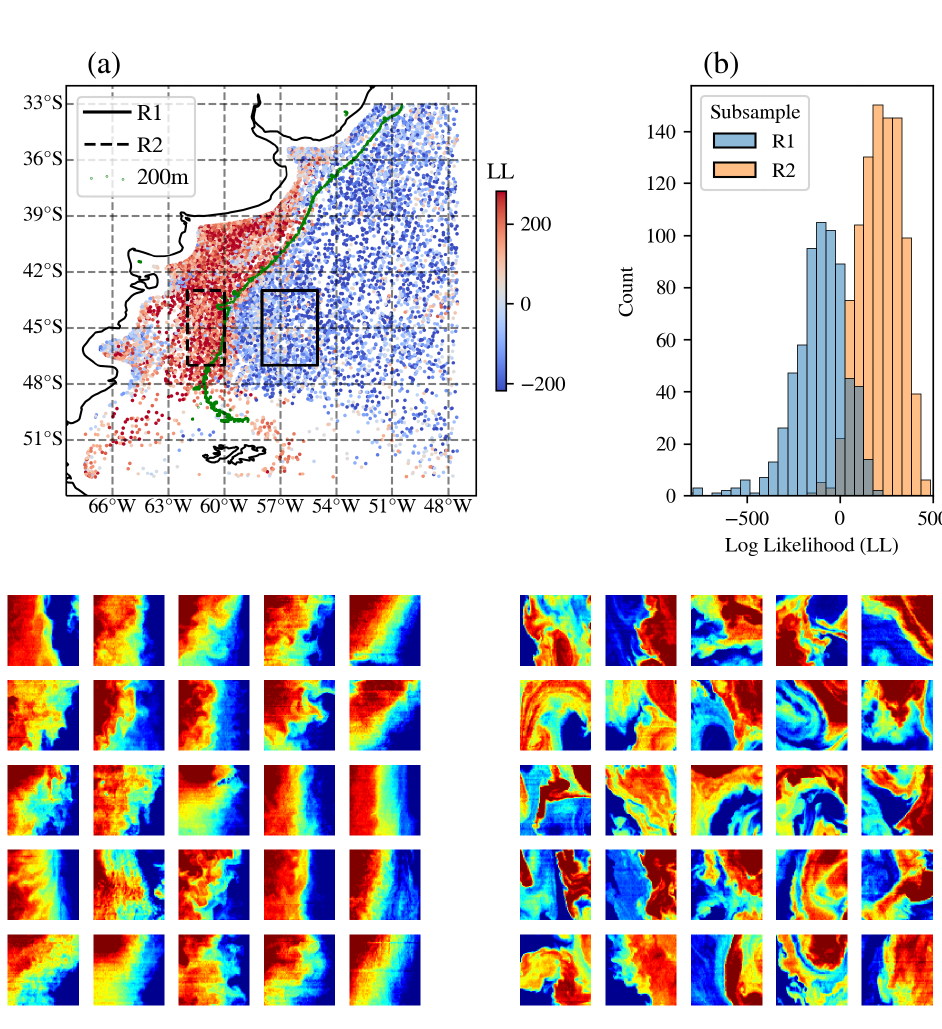
Figure 12. ( a ) Distribution of the LL values for cutouts near the Brazil–Malvinas Confluence, restricted to those with ∆ T ≈ 2K. One can identify a clear separation, where the lower LL values lie within the current and the higher values lie close to the Argentinian coast. Marked are two rectangles (R1 and R2), one in each region, referred to in the other panels. Marked also is the 200 m bathymetry described in the text. ( b ) Histograms of the LL values for the cutouts from two regions (R1/R2) chosen to show lower/higher LL values near the confluence. (lower panels) Representative cutouts from each subset—the left set was drawn from the R2 rectangle and therefore exhibit higher LL values. The right set was from R1. These galleries reveal qualitative differences in the SST patterns, i.e., unique ocean dynamics. The palette for the lower panels ranges linearly from − 1 to